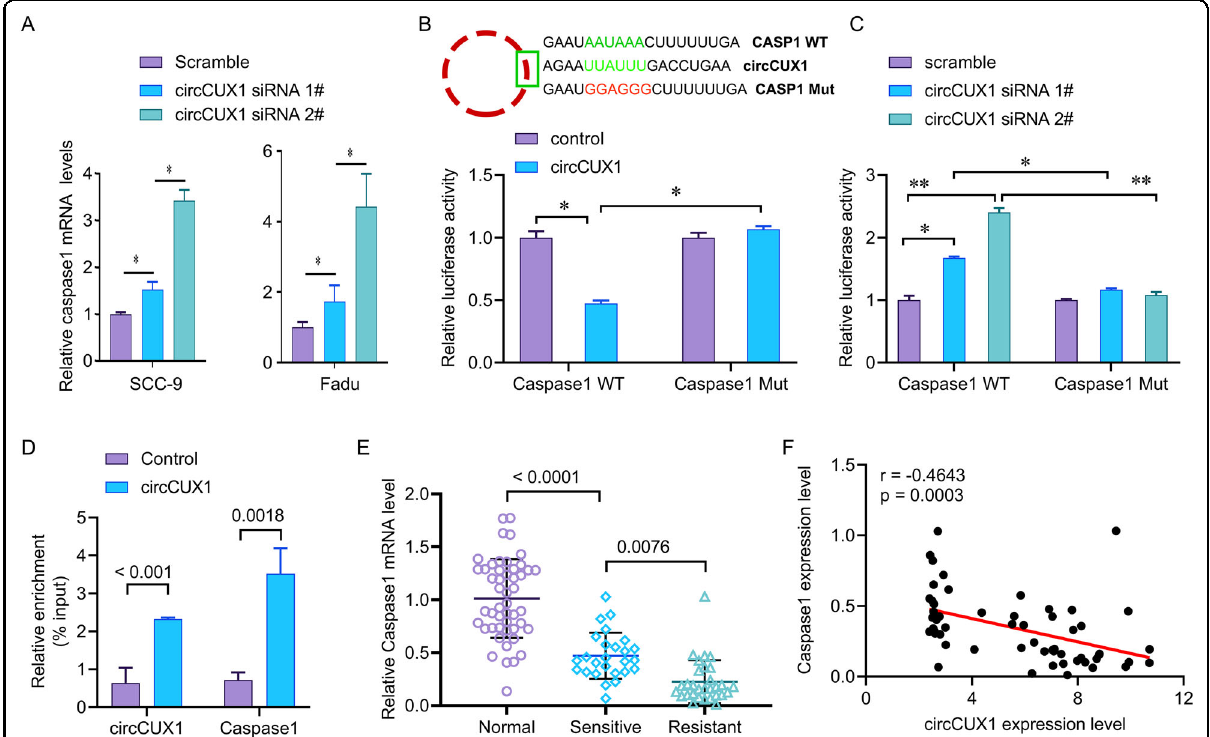
Fig. 6 CircCUX1 inhibits caspase1 mRNA. A qRT-PCR analysis for the expression of caspase1 after siRNA transfection in Fadu cells. B Relative luciferase activity of luciferase reporter gene with caspase1-WT or caspase1-Mut in control and circCUX1-overexpression Fadu cells. The wild type motifs were indicated by green and the mutant motif was indicated by red. C Relative luciferase activity of luciferase reporter gene with caspase1-WT or caspase1-Mut in control and circCUX1 knockdown Fadu cells. D Relative enrichment representing caspase1 and circCUX1 RNA levels associated with circCUX1 junction compared to control. E qRT-PCR analysis of caspase1 expression in radiosensitive ( N = 40) and radioresistant ( N = 38) HPSCC tissues and adjacent normal tissue ( N = 60). F circCUX1 expression showing negatively correlated with caspase1 expression in HPSCC patients ( N = 78). * p < 0.05, ** p <